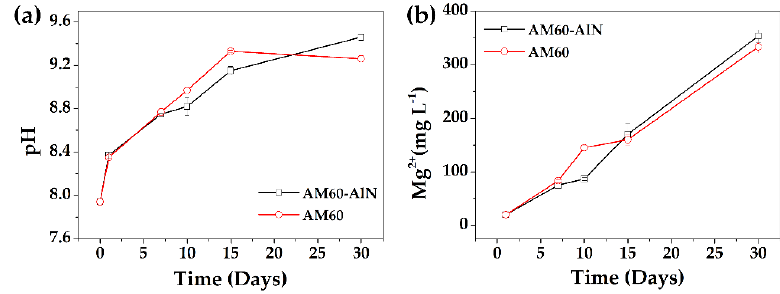
Figure 3. Changes in time of pH ( a ) and concentration of released Mg 2+ ions ( b ) after exposure